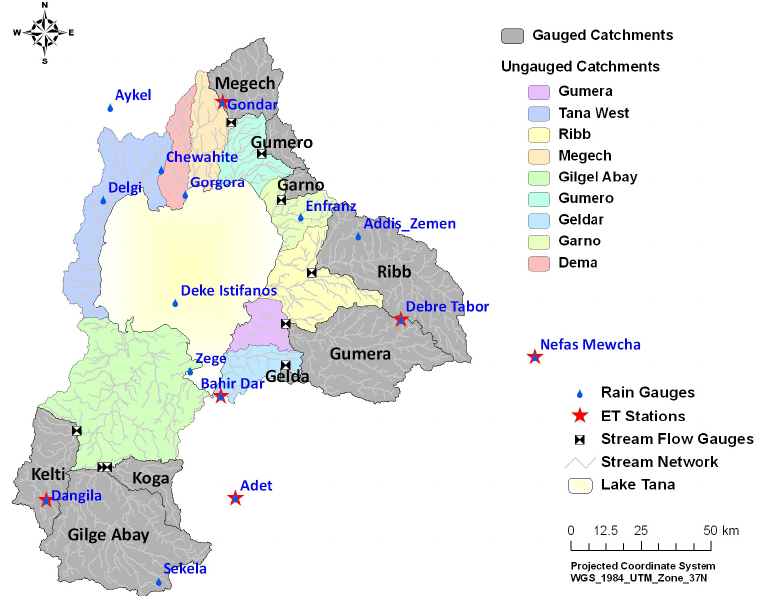
Fig. 1. Gauged and ungauged catchments in the Lake Tana basin. Weather and gauge stations are